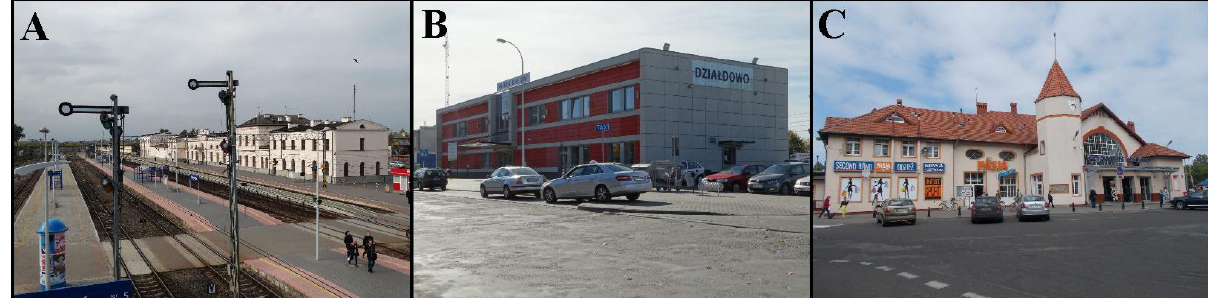
Fig. 1. Modernized railway stations in Bialystok (A), Działdowo (B) and Kołobrzeg (C)